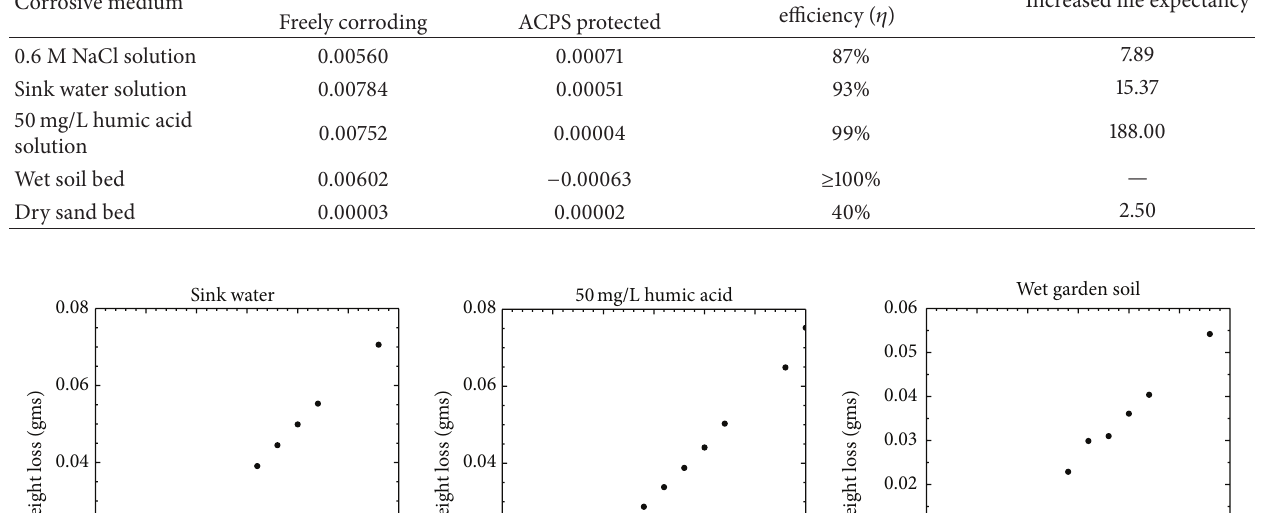
Table 3: The average weight loss per day for the freely corroding and the ACPS protected A36 steel sample in different corrosive mediums. Corrosive medium